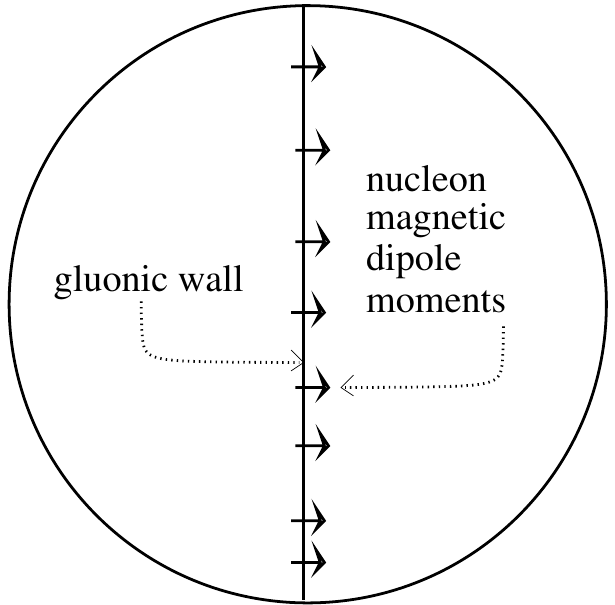
Figure 9. Magnetic field produced during the